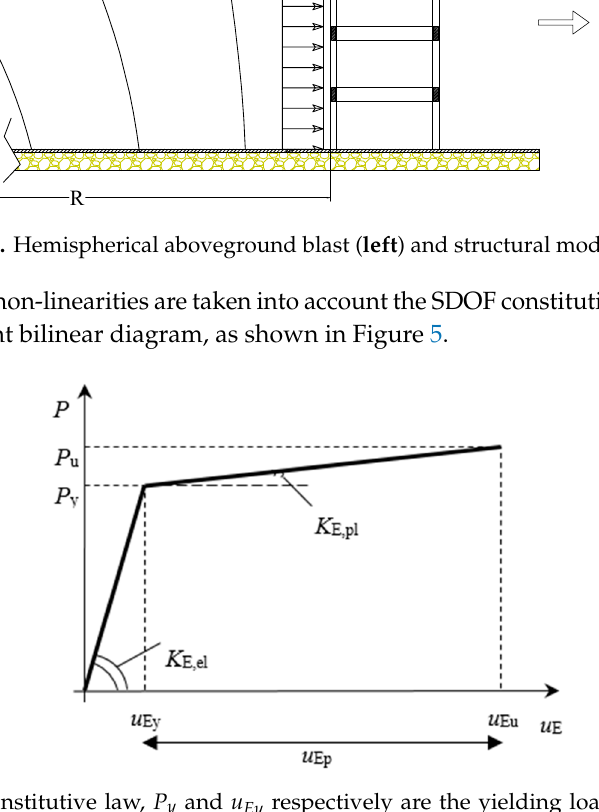
Figure 5. SDOF constitutive law, P y and u Ey respectively are the yielding load and displacement, while P u and u Eu are the corresponding ultimate ones. K E,el represents the elastic stiffness while K E,pl the plastic one.